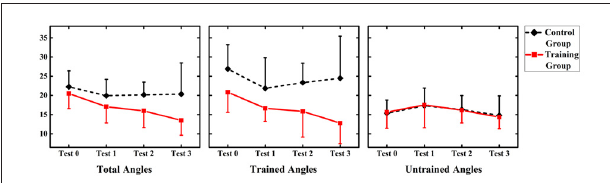
FIGURE 3 | Summary of mean absolute error (MAE) for the audiovisual training and control groups for three types of angles (total angles, trained angles and untrained angles). Error bars show the magnitude of one standard error.